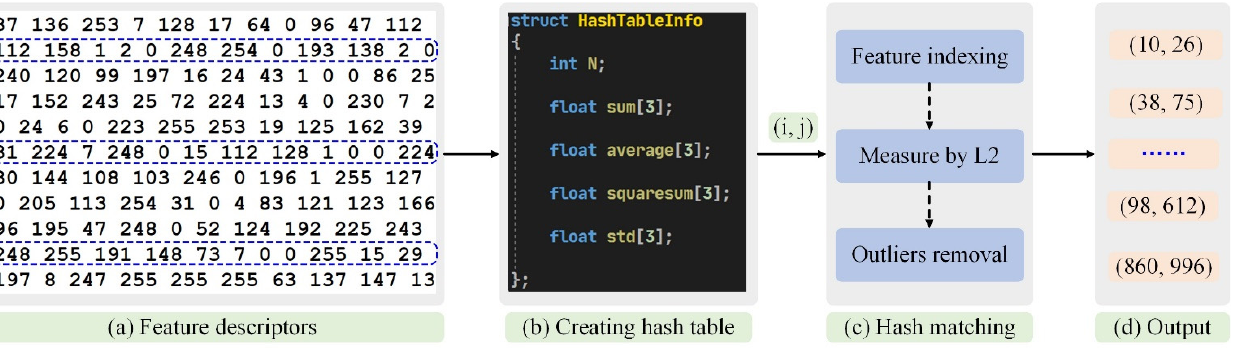
Figure 4. Flowchart of hash matching. Where ( a ) denotes the input feature descriptors, ( b ) represents the structure of the hash table in C-plus-plus language, ( c ) represents the pipeline of hash matching, and ( d ) denotes the output indexes of feature correspondences.